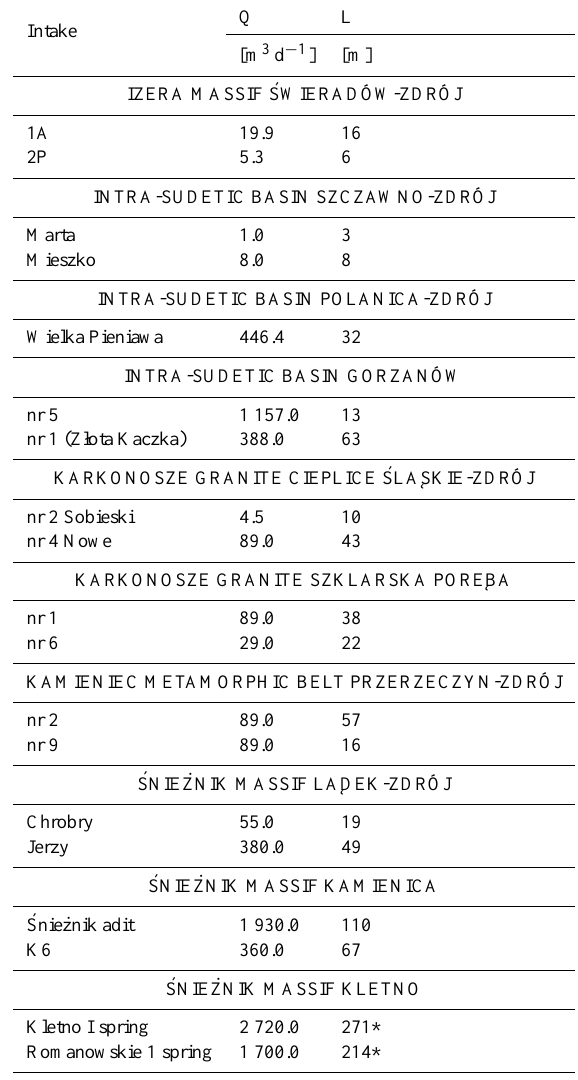
Table 4. The distance of 222 Rn atoms transport with groundwater to the intake (L) and the discharge of the intake (Q) for selected wells and boreholes in the Sudetes (according to Przylibski, 2005).